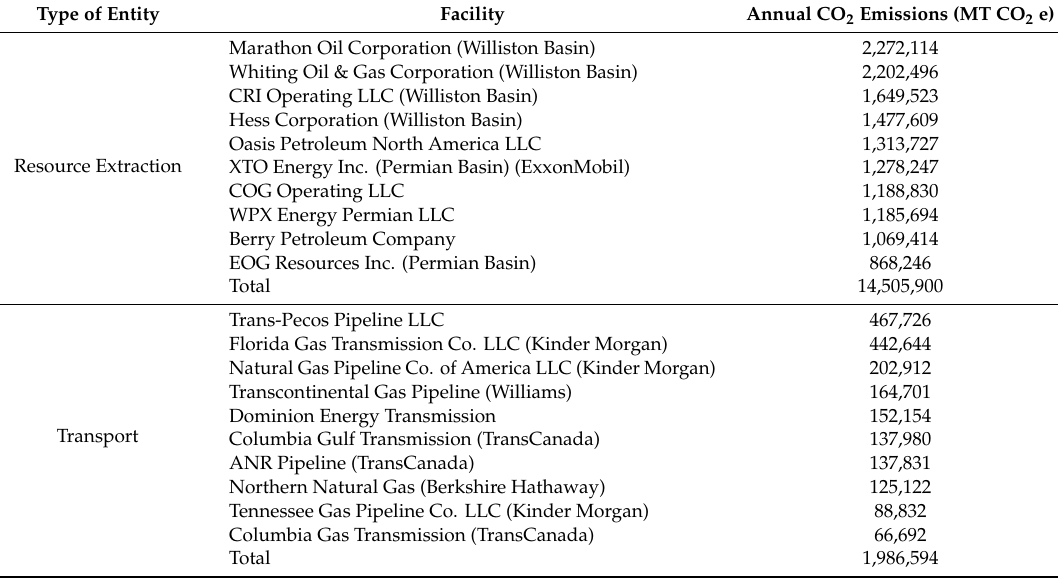
Table A3. Top CO 2 Emission Point-Sources of the Natural Gas Industry for Resource Extraction, Transport, and